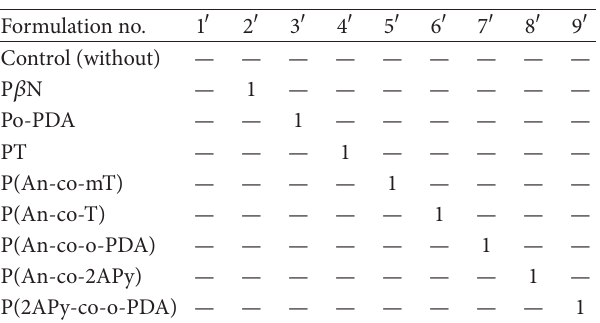
Table 3: SBR formulations containing the prepared homopolymers and